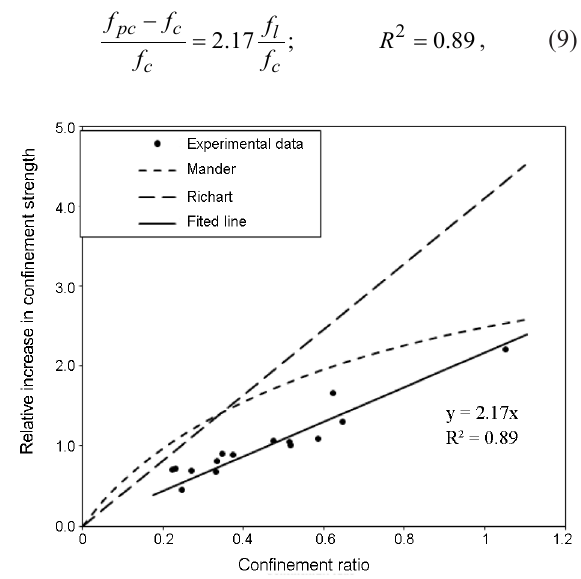
Fig. 4. Relationship of relative increase in confinement strength of NPCFT versus confinement